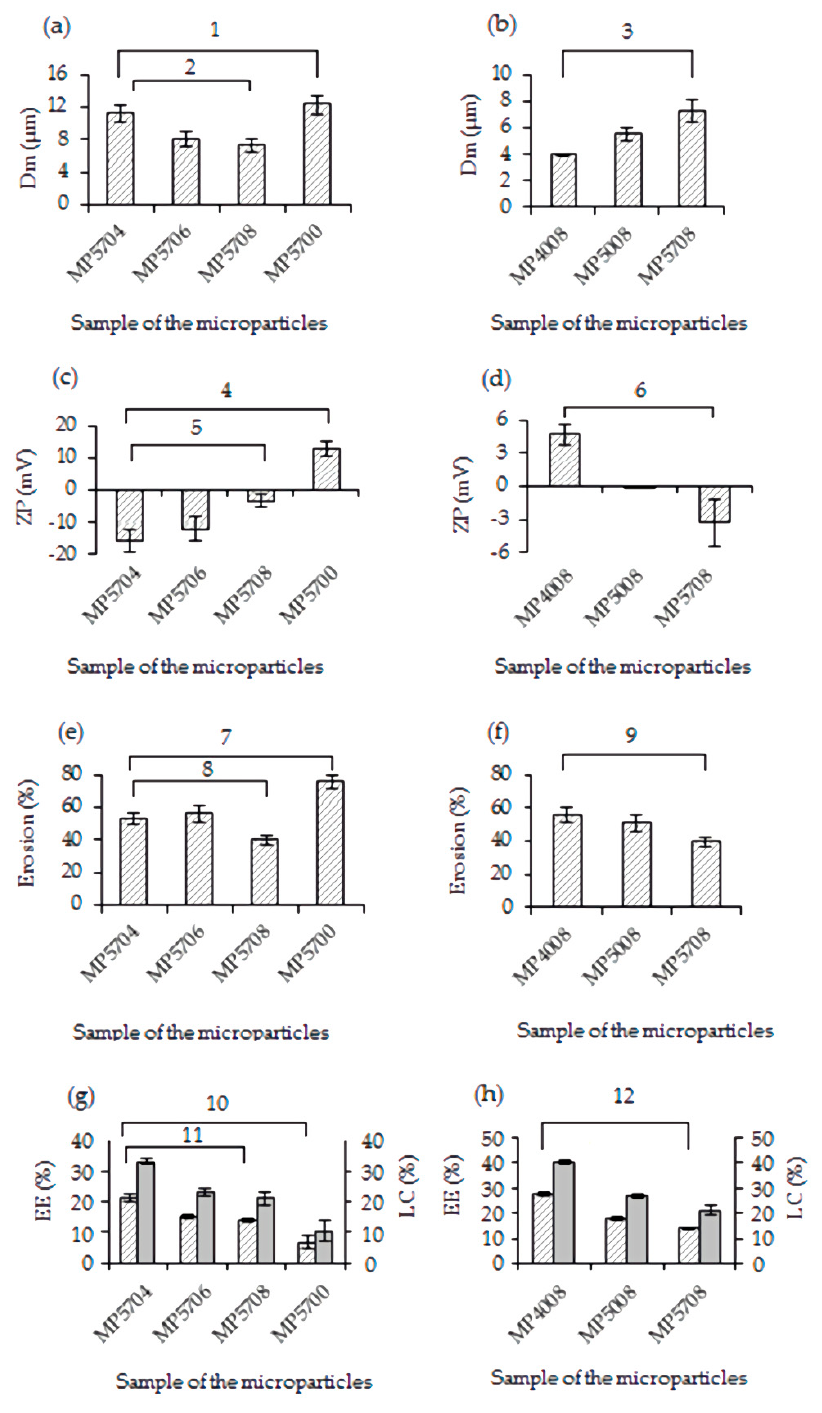
Figure 4. D m ( a , b ), zeta potential (ZP) ( c , d ), erosion ( e , f ), encapsulation efficiency (EE), and loading capacity (LC) ( g , h ) for the non-cross-linked and cross-linked chitosan microparticles prepared at different polymer-to-crosslinker ratios ( a , c , e , g ) and pH values ( b , d , f , h ). The p -values (1—8.48 × 10 − 4 ; 2—5.26 × 10 − 3 ; 3—1.14 × 10 − 3 ; 4—2.1 × 10 − 7 ; 5—2.72 × 10 − 3 ; 6—2.13 × 10 − 3 ; 7—1.59 × 10 − 7 ; 8—1.33 × 10 − 3 ; 9—4,15 × 10 − 3 ; 10—6.92 × 10 − 6 ; 11—9.83 × 10 − 5 ; 12—4.78 × 10 − 7 ) were obtained from the one-way analysis of variance (ANOVA).